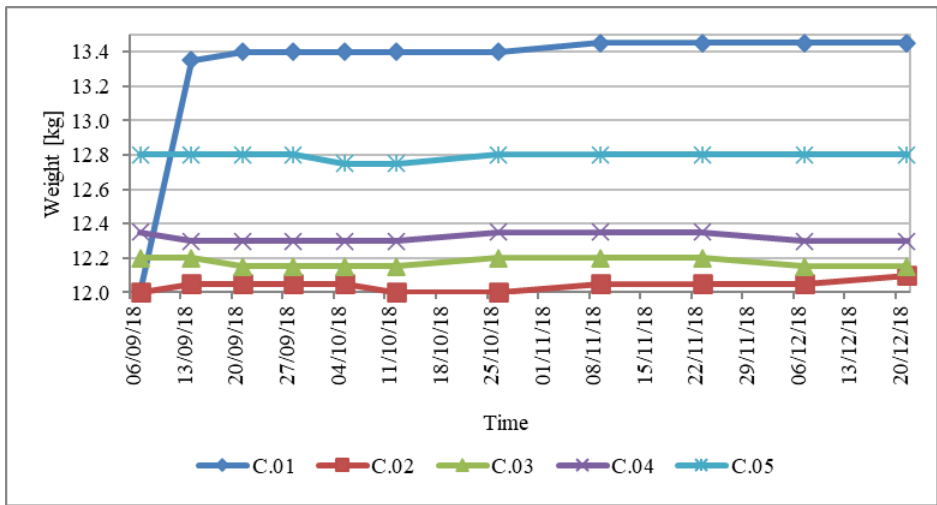
Figure 4. Weight-time absorption curves for the carparo column (C.).